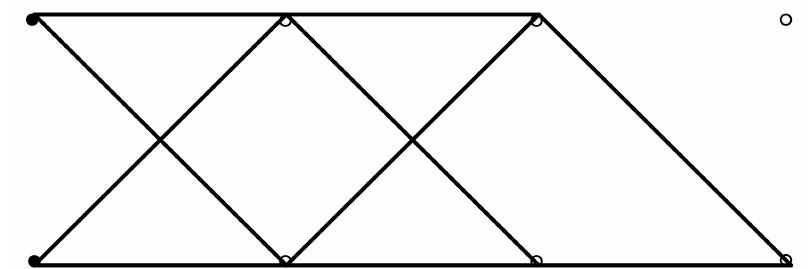
Figure 8. Topology evolution of the 15-bar truss.